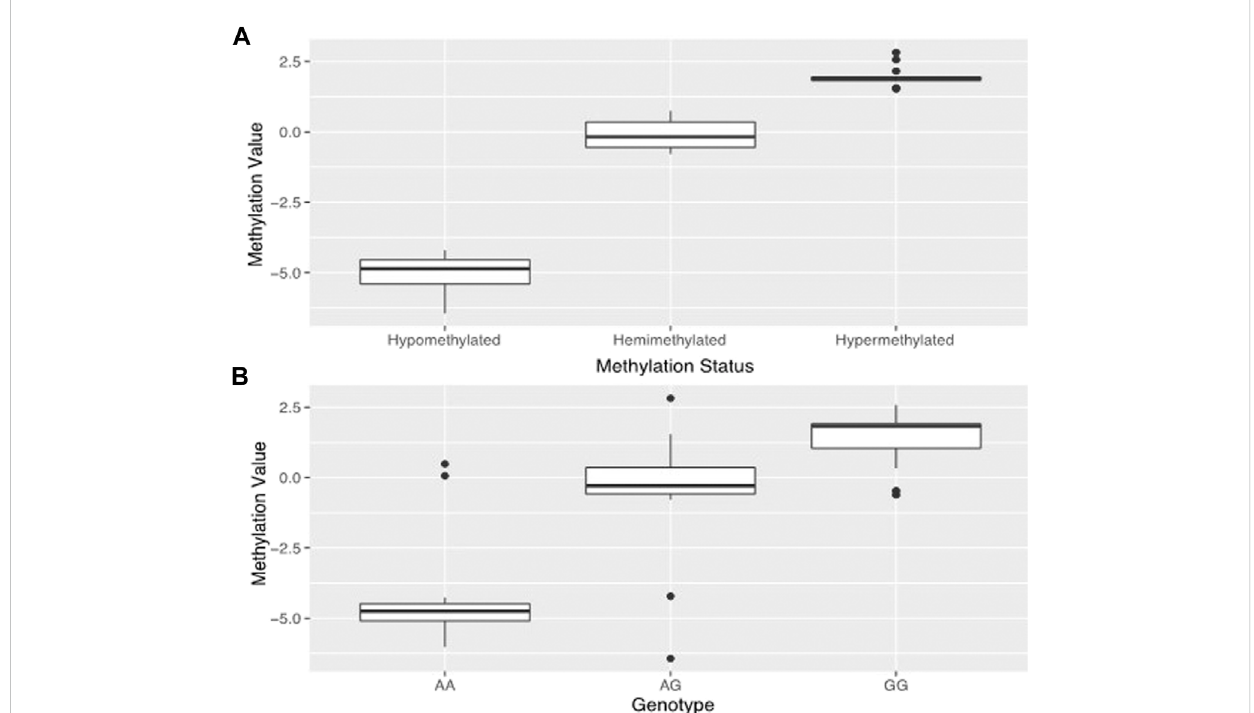
FIGURE 2 Estimated genotypes based on methylation. Prediction and con fi rmation of genotype using DNA methylation status at methylation probe cg09829645 which is in the same location as dysferlin variant rs10166384. Data used to generate (A) was taken from the 45 samples used in the original study. (A) showsthetripartitedistributionofmethylationlevelsdetectedfordysferlinatHM450kmethylationprobecg09829645inthe45placentas from ouroriginalstudy(Gundlingetal.,2018).Onegroupishypomethylated,onegroupishemimethylated,andonegroupishypermethylated. (B)